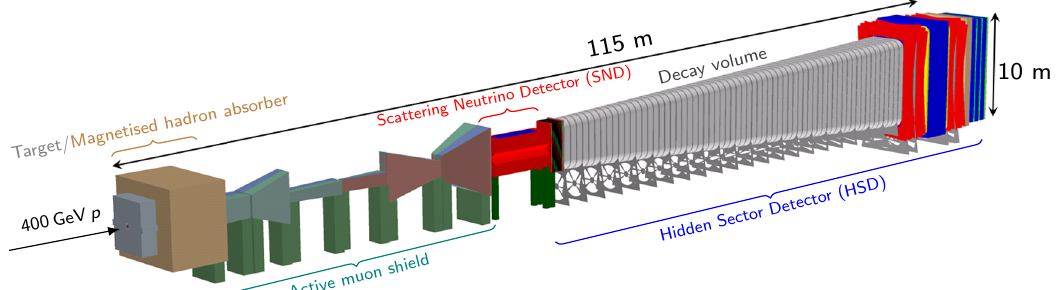
Figure 1. Overview of the SHiP experimental layout.